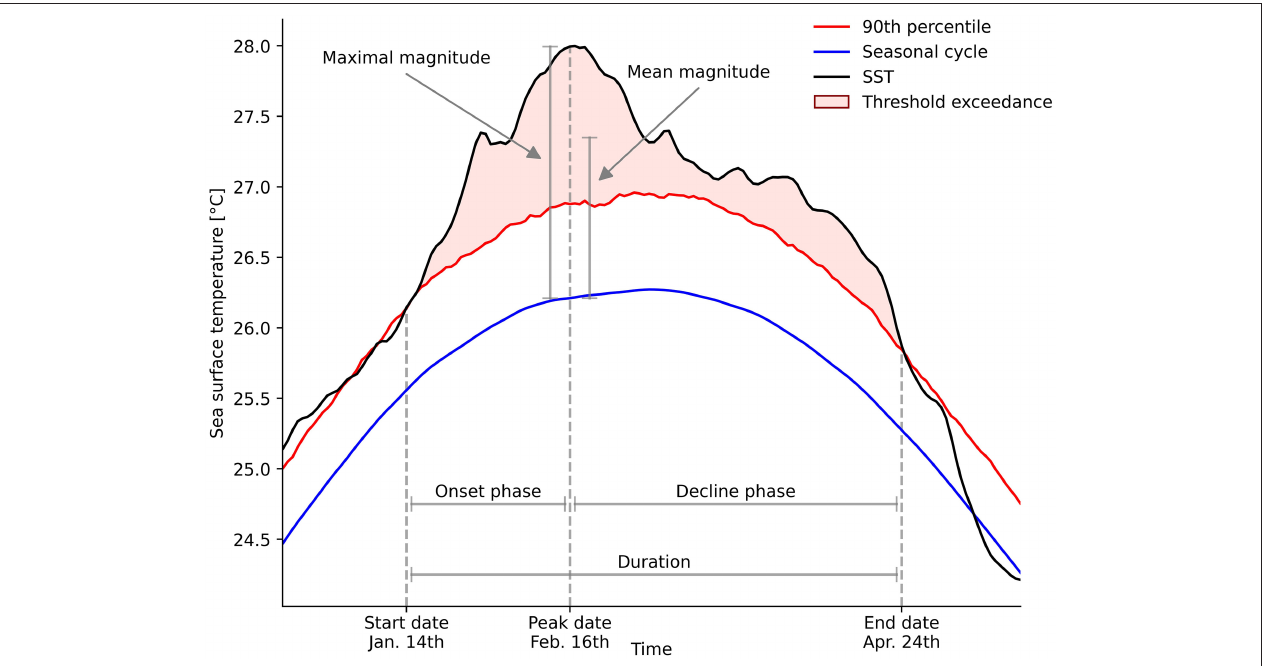
FIGURE 1 | Schematic figure illustrating the definition of a marine heatwave (MHW) and associated characteristics used in this study. The time series of simulated sea surface temperature (SST) averaged over the 55 ◦ E–105 ◦ E and 15 ◦ S–30 ◦ S region in the subtropical Indian Ocean for year 175 of the preindustrial control simulation is shown in black. The climatological seasonal cycle is shown in blue and the 90th percentile threshold in red. The red shaded area indicates the occurrence of the MHW. The period between the start (Jan 14th) and the peak (Feb 16th) of the MHW is labeled as the onset phase. The period between the peak and the end (Apr 24th) is labeled as the decline phase. The time span between start and end indicates the duration. Also shown are the maximum magnitude (maximal SST anomaly relative to the seasonal cycle) and the mean magnitude (SST anomaly averaged over the duration of the event).